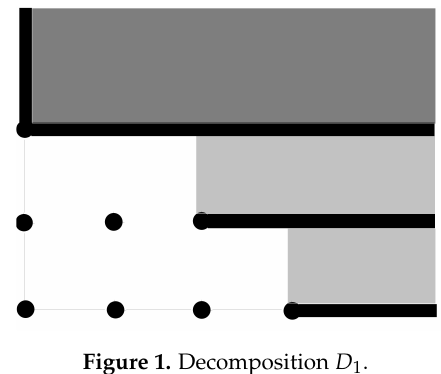
Figure 1. Decomposition D 1 .